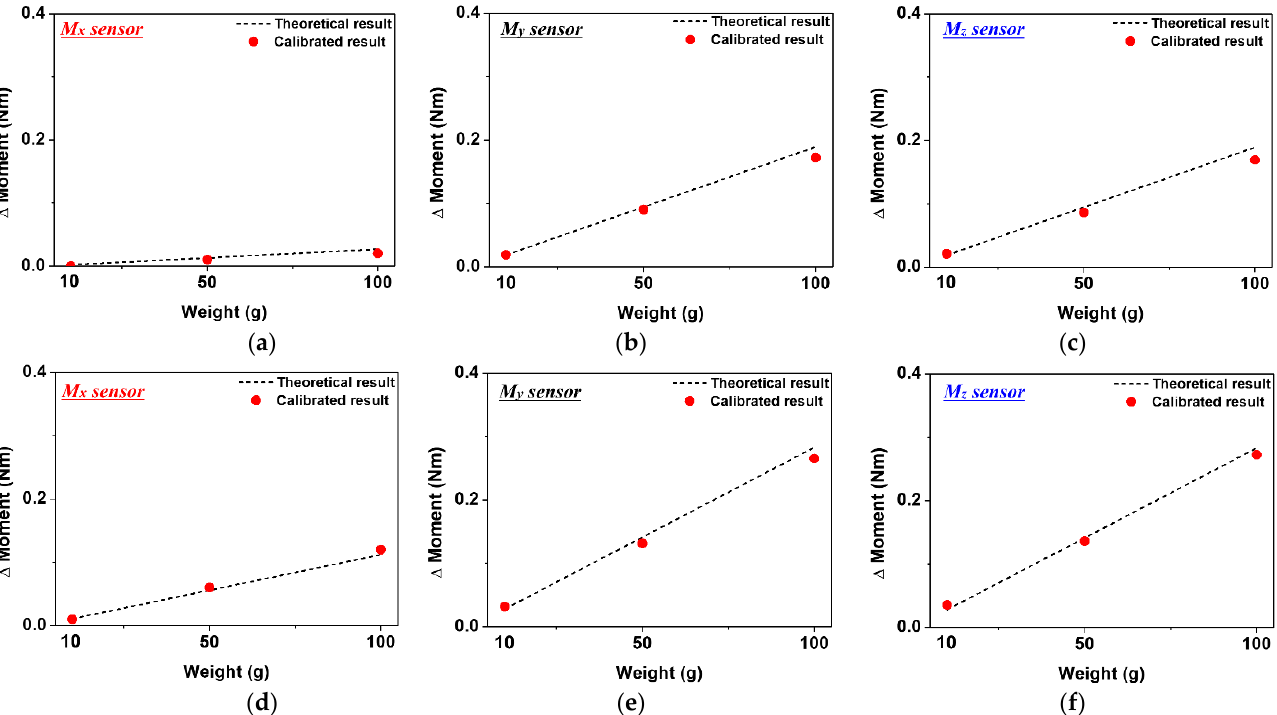
Figure 10. The evaluation result of micro external force detection performance of three-axis sensor by weight: ( a ) the measurement result of the Mx sensor without initial weight; ( b ) the measurement result of the My sensor without initial weight; ( c ) the measurement result of the Mz sensor without initial weight; ( d ) the measurement result of the Mx sensor under 10 kg weight; ( e ) the measurement result of the My sensor under 10 kg weight; ( f ) the measurement result of the Mz sensor under 10 kg weight.